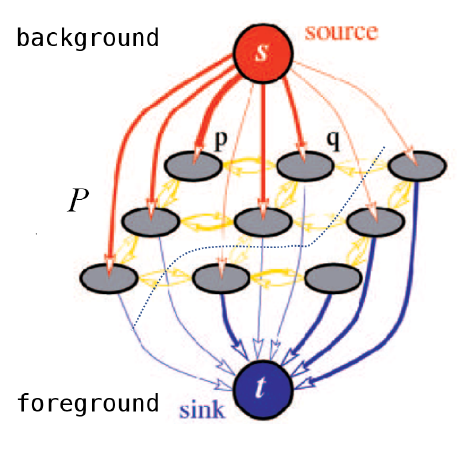
Figure 3. The graph structure of cosegmentation (adapted from